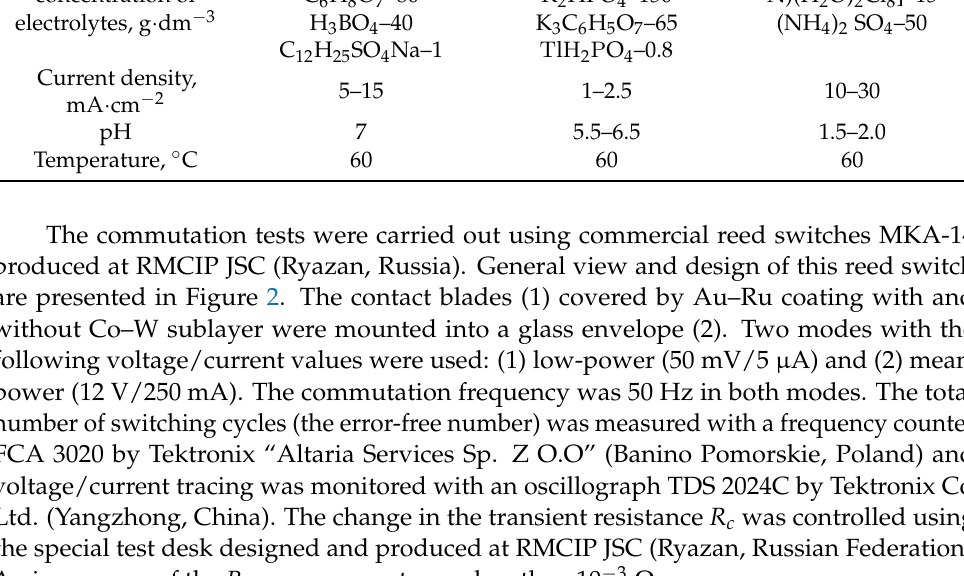
Figure 1. The structure of Au – Ru layers-based contact coatings with and without Co – W barrier sublayer.